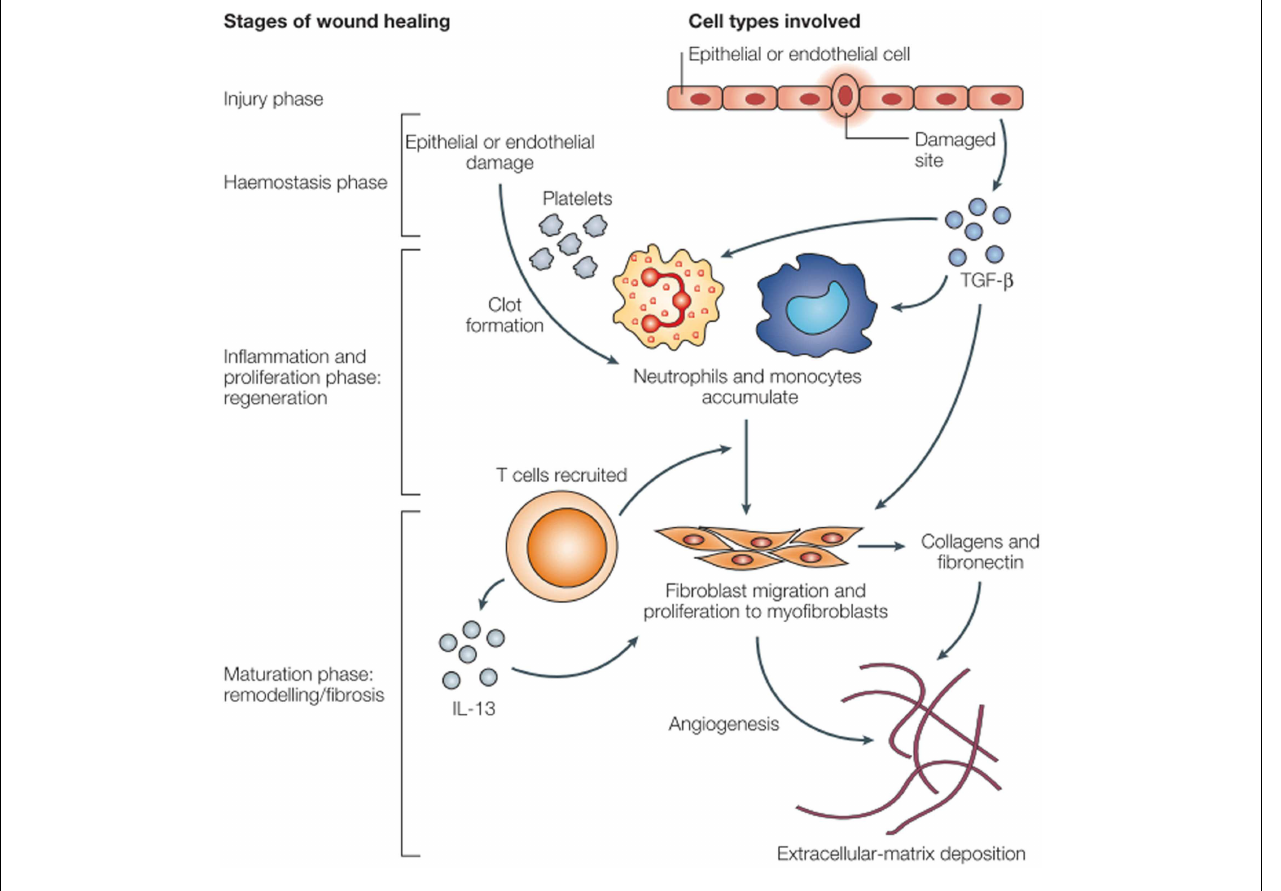
FIGURE 1 |Wound healing and fibrosis in tissue (17)